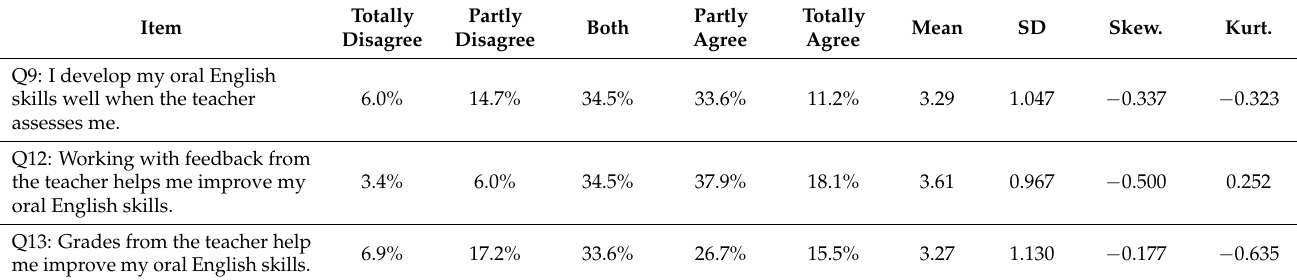
Table 7. Students’ perceived learning outcomes from assessment by the